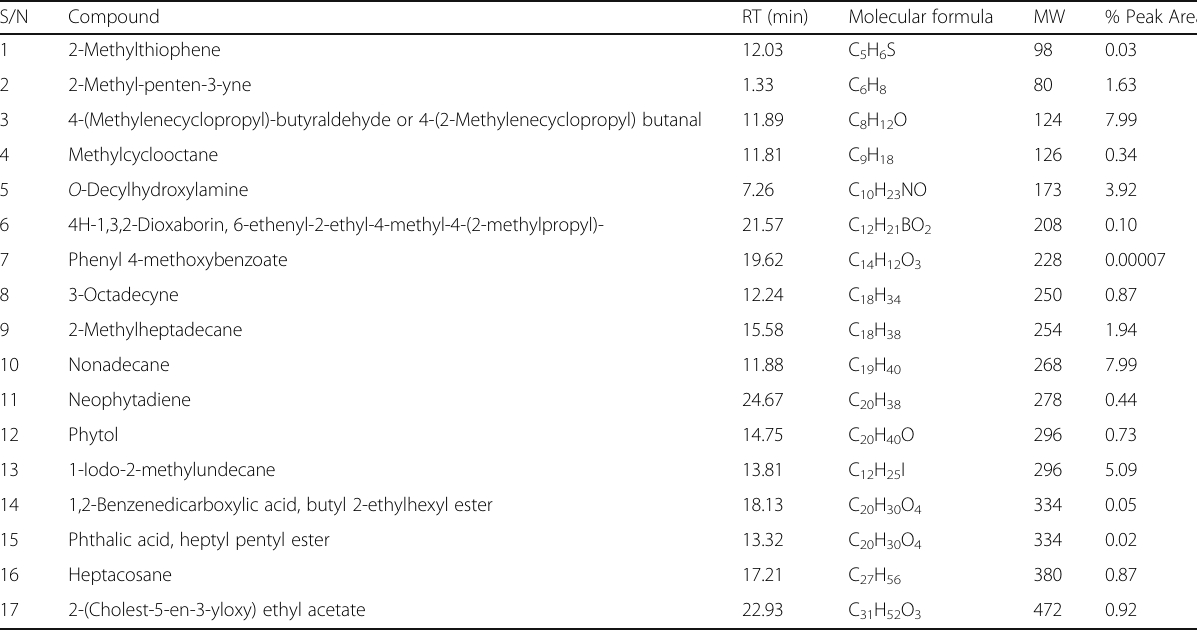
mL) while rotundic acid was relatively cytotoxic to the that the active compounds were relatively non-polar. tested cell line with an LC The total activity of the fractions against M. smegmatis , value of 33 μ g/mL. Lutein also 50 M. aurum , M. tuberculosis (8104) and M. fortuitum were had low toxicity against RAW 264.7 macrophages, support- 11.7, 13.5, 7.1. and 49.0 L respectively (Table 2). ing the results found by Rafi and Shafaie [38]. The higher the selectivity index the higher the potential safety of the extract or compound when used in vivo. The selectivity Cytotoxic activity and inhibition of NO production index (SI) value obtained in this study for the fractions Fractions F and F had some degree of toxicity against 9 10 ranged from 0.02 to 3.27 with fraction F C3A human liver cells while other fractions had relatively having the highest 8 moderate cytotoxicity against this cell line. Lutein was not value against M. smegmatis (Table 3). Most of the fractions cytotoxic even at the highest tested concentration (200 μ g/ appeared to be more toxic to the human cells than to the Table 1 Bioactive compounds detected in the acetone crude extract of Oxyanthus speciosus S/N Compound RT (min) Molecular formula MW % Peak